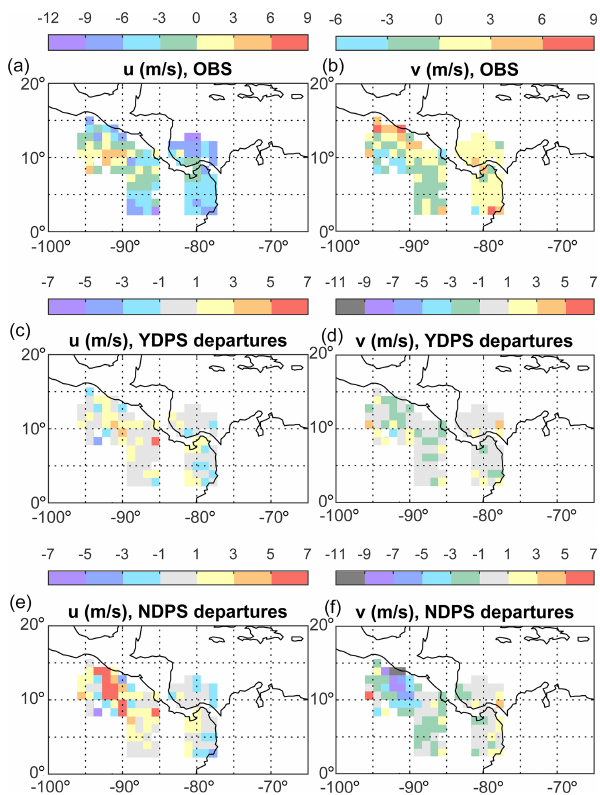
Figure 3. The horizontal distribution of mean departures (defined in Eq. 1) for (a, c, e) mixing ratio and (b, d, f) potential temperature, at 700hPa. (a, b) Mean dropsonde observations. (c, d) Departures of the control (YDPS) experiment. (e, f) Departures of the denial (NDPS)